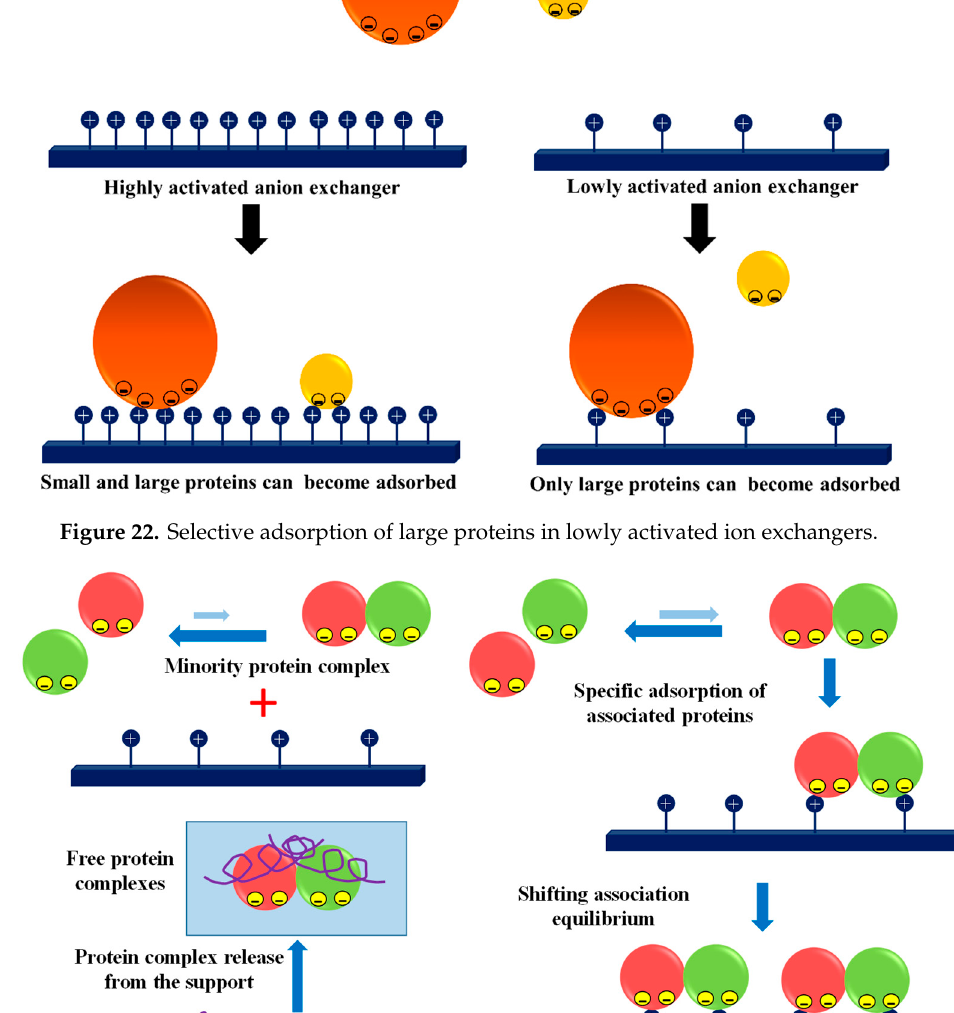
Figure 24. Controlling the aggregation of BSA by controlling the activation of ion exchangers and final crosslink of the BSA complexes with dexOx. 4. Conclusions As shown throughout this article, dexOx is a very useful reactive polysaccharide within the field of biocatalysis. Its easy use, as well as the multiple applications that it presents, make dexOx an extremely valuable biomolecule to solve some critical situations in biosensor and biocatalysts design, including not only enzyme immobilization but also purification. The key for its applicability is the mobility and inertness (after chemical reduction) inherent to dexOx, while this flexibility helps the enzyme stabilization via rigidification complex. Thus, its application in the design of matrices for affinity chromatography and production of biosensors is based on these features. The huge amount of reactive groups inside dexOx and its large size make it very convenient for stabilization of